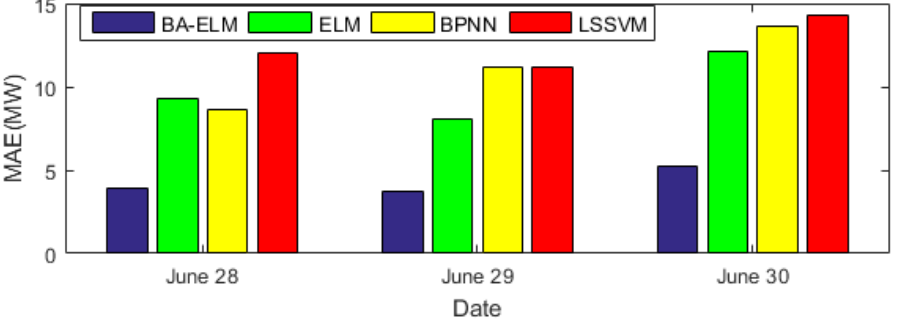
Figure 16. Mean absolute error (MAE) of different models in testing period.